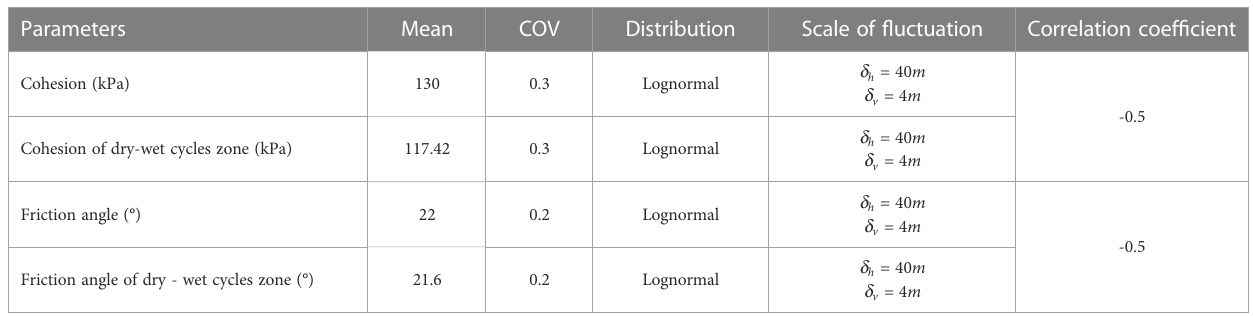
TABLE 2 Statistical mechanical parameters of sliding mass.